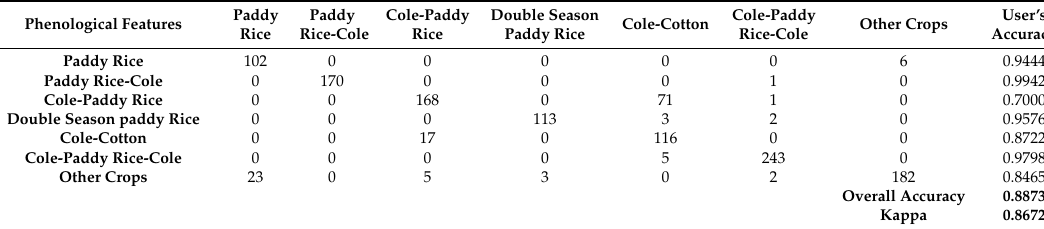
Table 5. Confusion matrix of classification using phenological features.